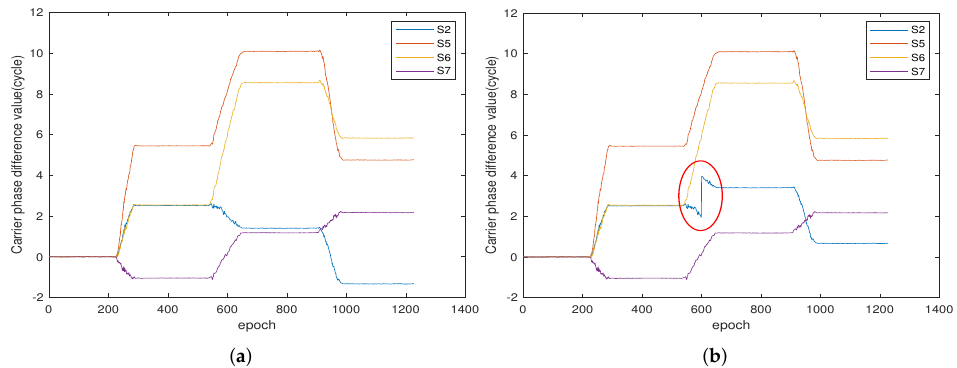
Figure 13. Carrier phase data after differencing from base station one ( a : no cycle slips, b : a cycle slip occurred at the 600 epoch of station